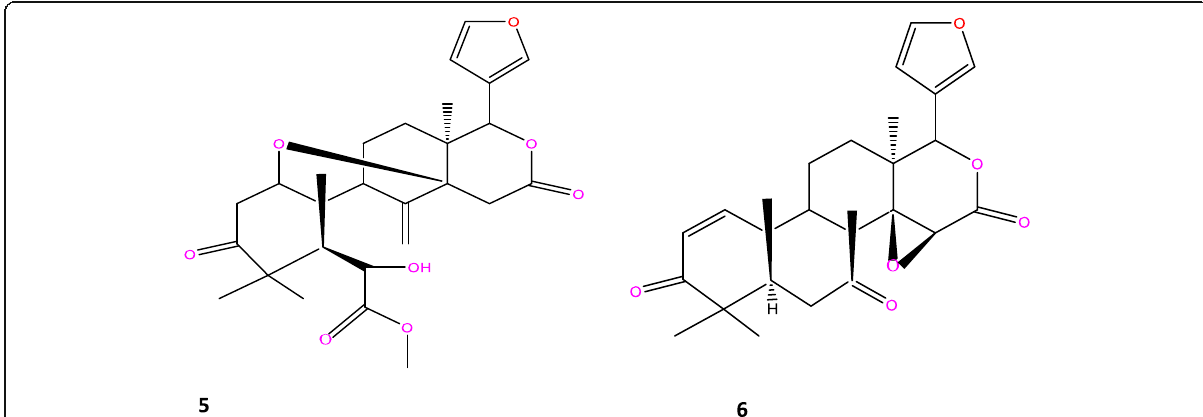
Fig. 8 Structure of limonoids from the stem bark of K. grandifoliola (5) 17-epi-methyl-6-hydroxyangolensate. (6) 7-deacetoxy-7-oxygedunin. Adapted from [49]